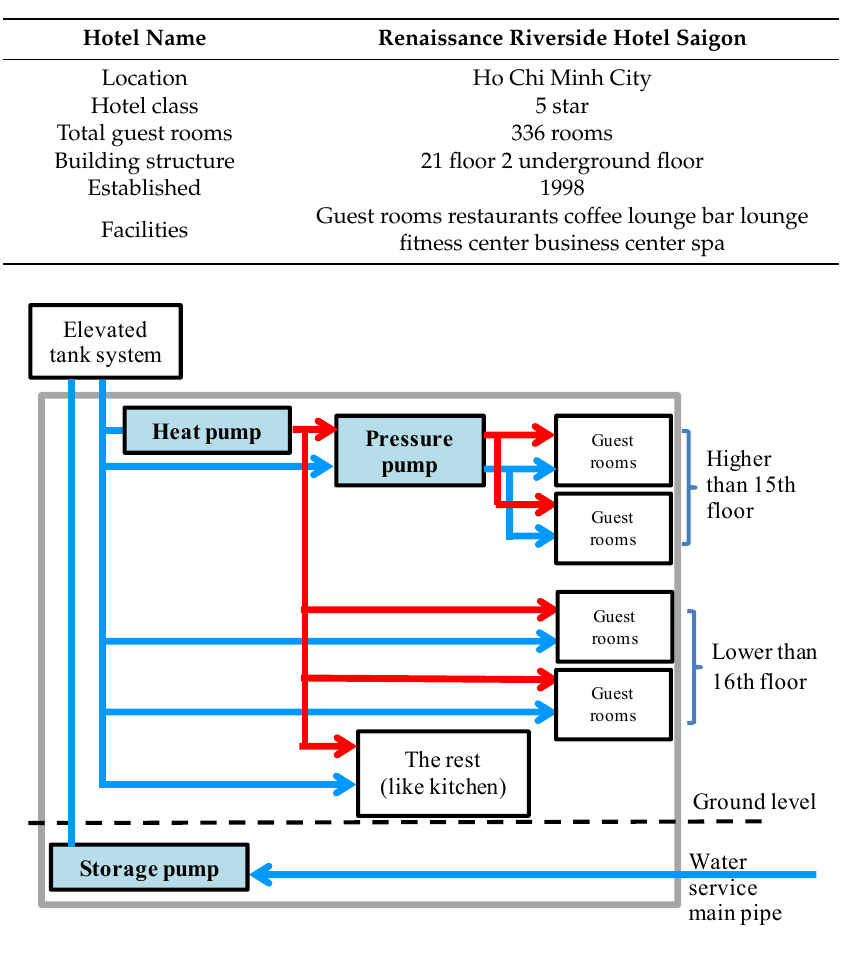
Figure 1. The facilities for supplying hot and cold water.